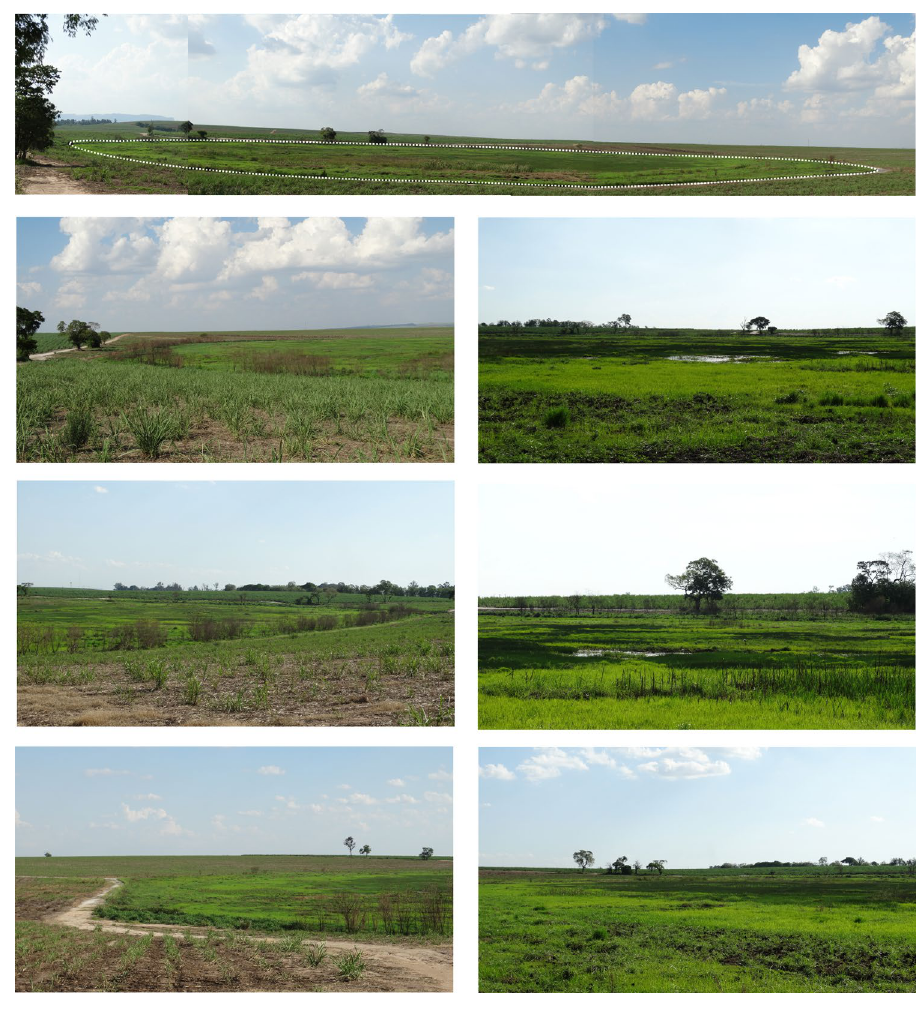
Fig. 2 Set of images of the study area, with panoramic image, limits with sugar- cane area, and details of the flooded region